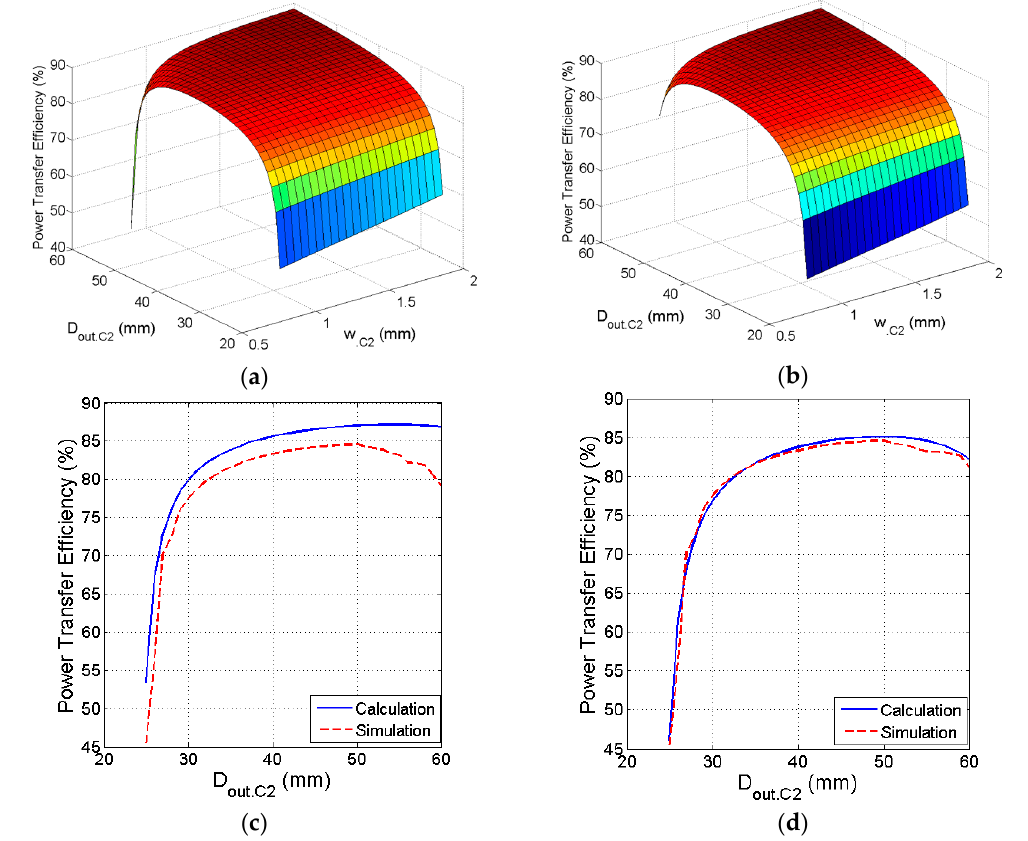
Figure 11. Optimization of the trace line width and size of the primary PSC. ( a ) Efficiency versus line width versus outer diameter of the square coil; ( b ) Efficiency versus line width versus outer diameter of the circular coil; ( c ) Calculated and simulated efficiency versus outer diameter of the square coil; ( d ) Calculated and simulated efficiency versus outer diameter of the circular coil.